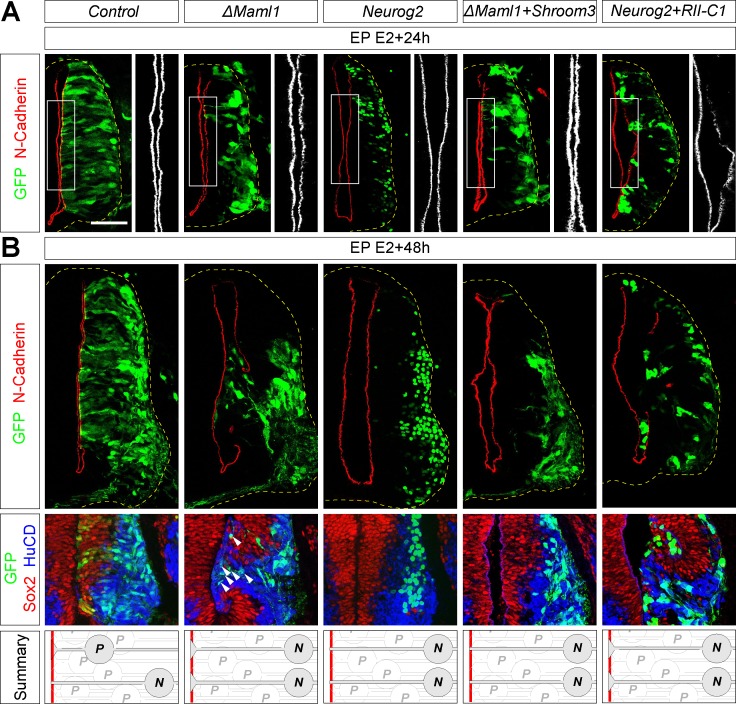
Effects of Notch signaling and apical constriction modulators on apical markers and tissue integrity.(A) Transverse sections of the NT transfected at E2 with the indicated constructs, harvested at E3 and immunostained for N-Cadherin (red). (B) Transverse sections of the NT transfected at E2 with the indicated constructs, harvested at E4 and immunostained for N-Cadherin (red); and for Sox2 (red) and HuCD (blue) to label progenitors and neurons, respectively. Transfection is reported by GFP expression. Summary: Schematic of the effects observed on tissue integrity. Gray cells correspond to electroporated cells. Scale bar represents 50 μm. See also S4 Fig. ΔMaml1, dominant-negative Mastermind-like 1; E, embryonic day; EP, electroporation; GFP, green fluorescent protein; HuCD, neuron-specific RNA-binding proteins HuC and HuD; N, neuron; Neurog2, Neurogenin 2; NT, neural tube; P, progenitor; RII-C1, Shroom3 binding site on ROCK2; Shroom3, Shroom family member 3; Sox2, SRY (sex determining region Y) box 2.